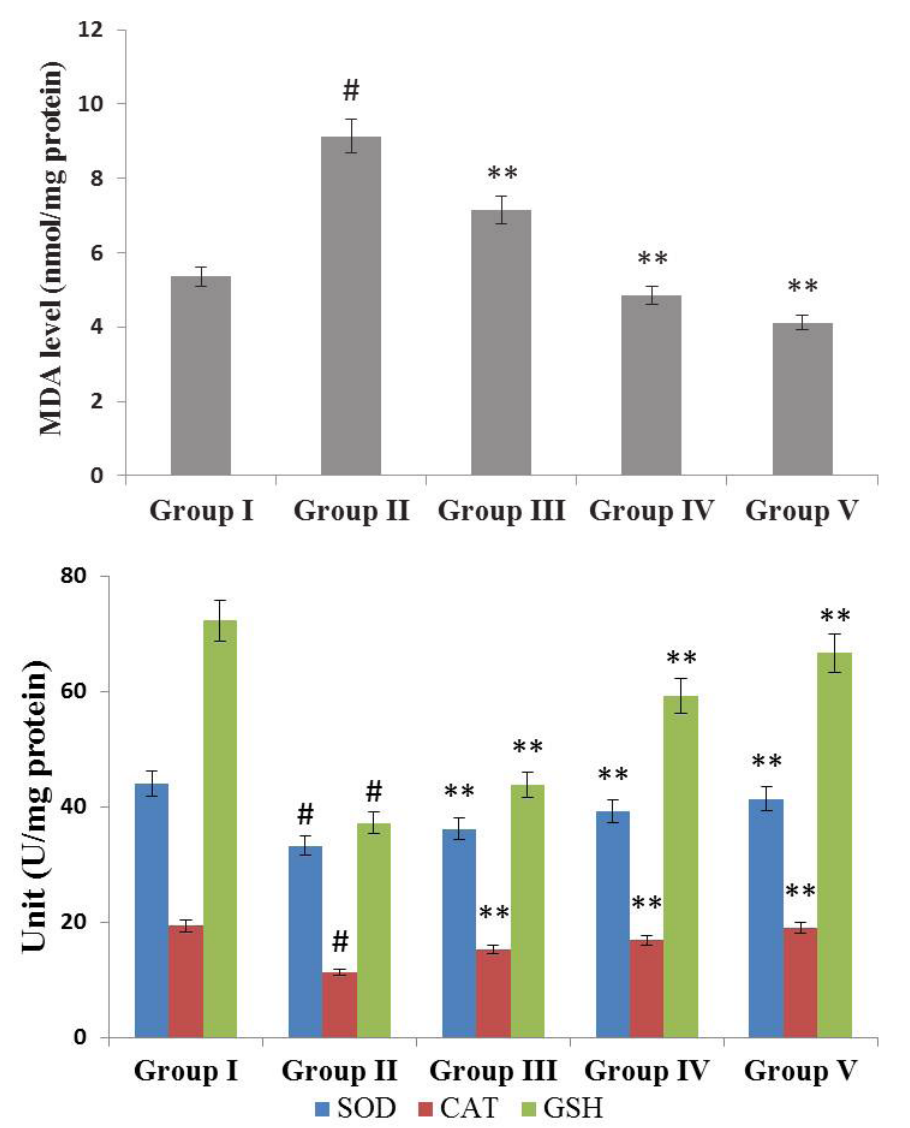
FIGURE 4 - Effect of ginkgolic acid on oxidative stress markers in CFA-induced arthritic rats. (A) Effect on the levels of MDA formation; (B) Effect on the levels of SOD, CAT and GSH. Values expressed as mean ± SEM (n = 8) and analyzed by one- way ANOVA followed by Tukey’s multiple comparisons test. # p < 0.05 as compared to normal control group I. ** p < 0.01 as compared to CFA group